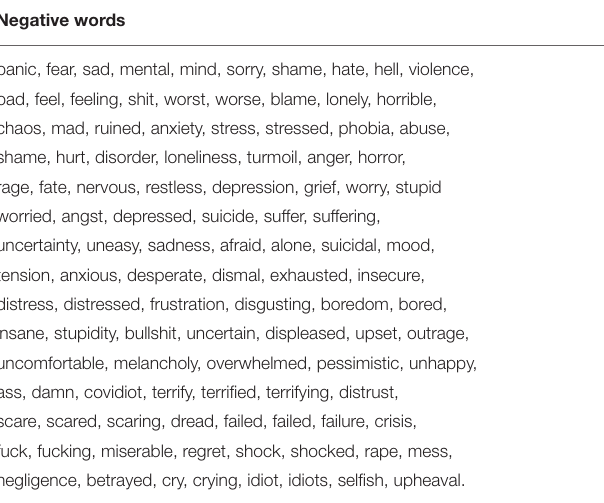
TABLE 1 | List of negative